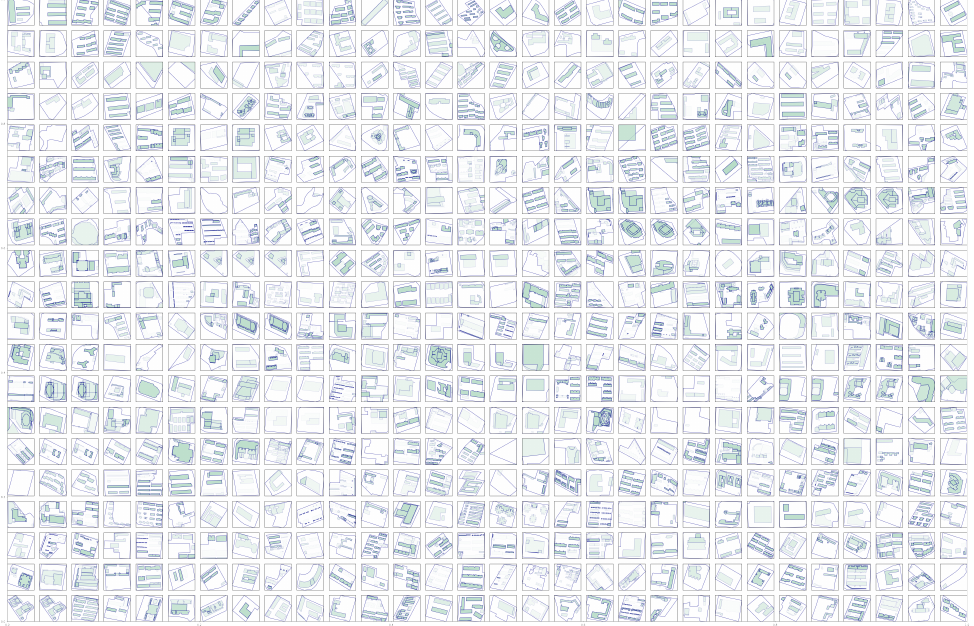
Figure 2. Examples of plot slices including AOI and